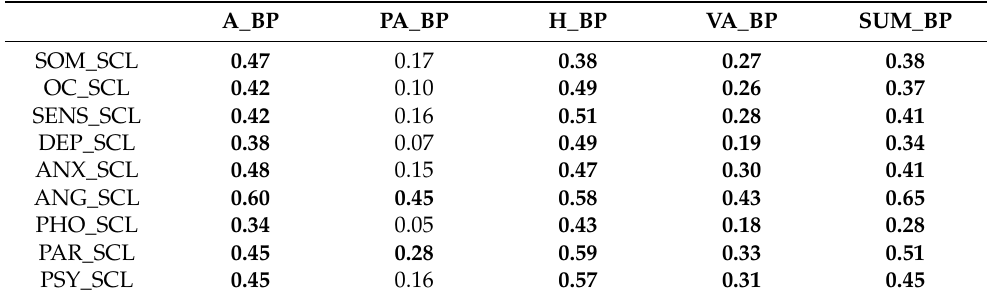
Table 4. Analysis of Spearman’s rank correlation between psychological traits in patients under